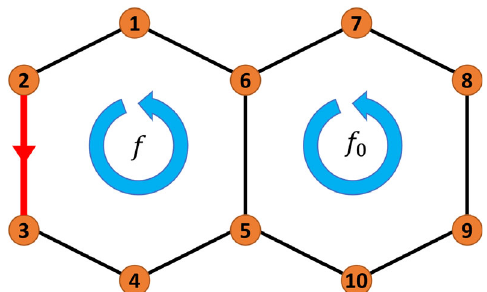
FIG. 2. An illustration of the two-cycle model Markov jump model. The model consists of ten sites arranged in two rings, with sites 5 and 6 shared between the two rings. The transitions between the sites are given by the rates Eq. (50) with a bias f in the left and f 0 in the right ring. The current is measured between sites 2 and 3 (red